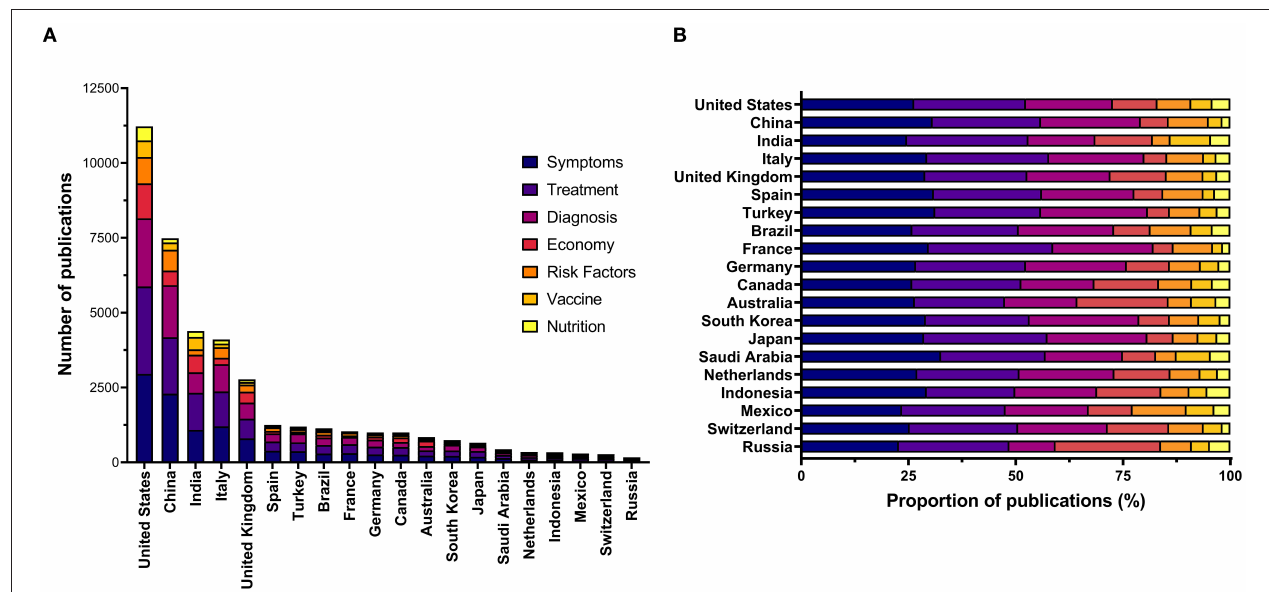
FIGURE 3 | Total number (A) and proportion (B) of early publications involving authorship from a single country on COVID-19 from the 20 highest-ranked countries according to gross domestic product.